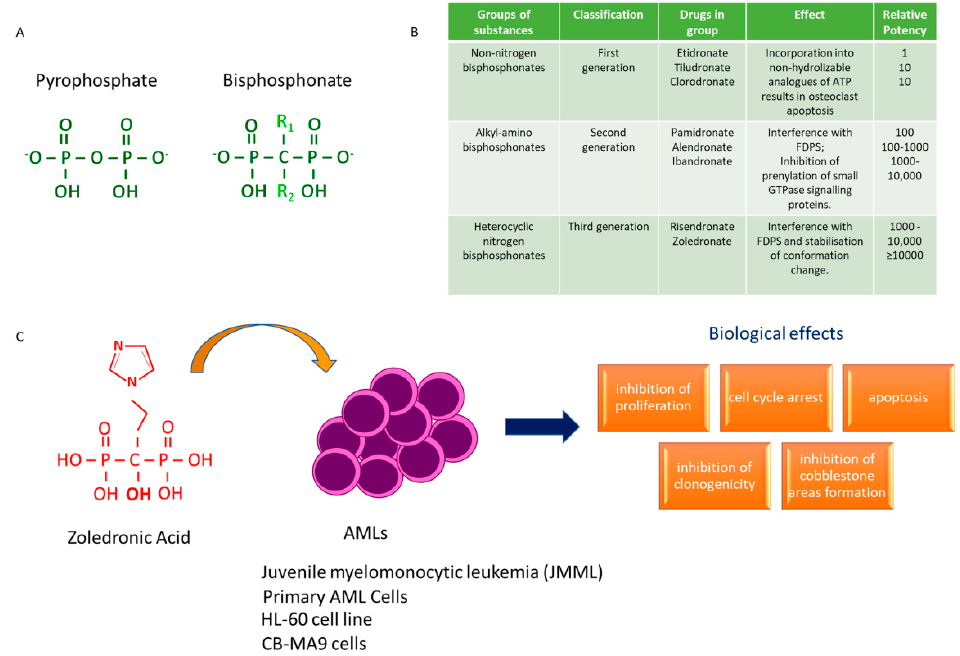
Figure 4. Biological effects of bisphosphonates on acute myeloid leukemia (AML). ( A ) Structural similarities between endogenous inorganic pyrophosphate and bisphosphonate. ( B ) The inhibitory effects of early bisphosphonates, second- and third-generation bisphosphonates on osteoclast dif- ferentiation/function via blocking the activity of farnesyl pyrophosphate synthase (FDPS). ( C ) The anti-tumor effects of zoledronic acid on acute leukemic cells.